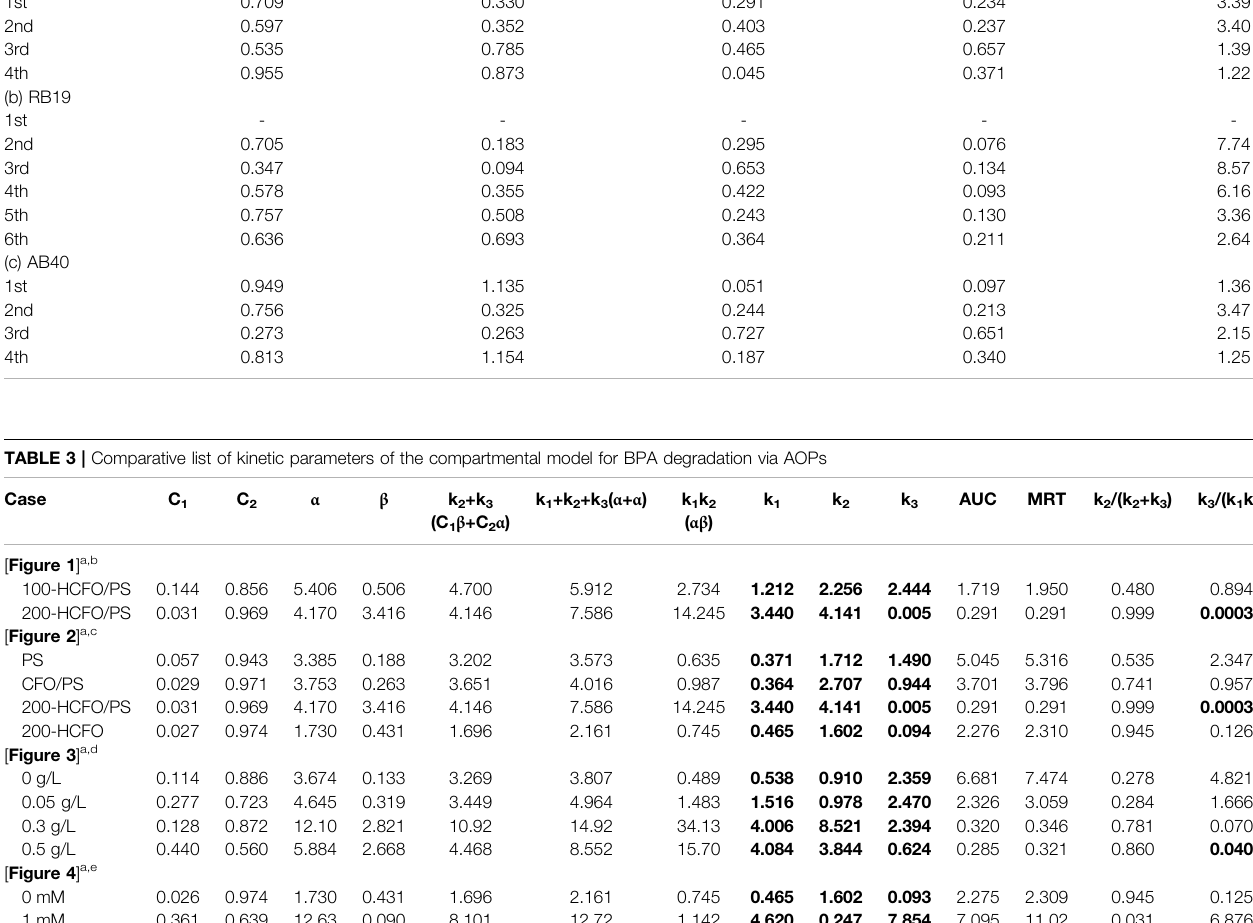
TABLE 2 | Tabulated list of kinetic parameters for the biodecolorization of anthraquinone dyes using the HS consortium: (a) acid blue 25 (AB25); (b) reactive blue 19 (RB19); and (c) acid blue 40 (AB40). Cycle